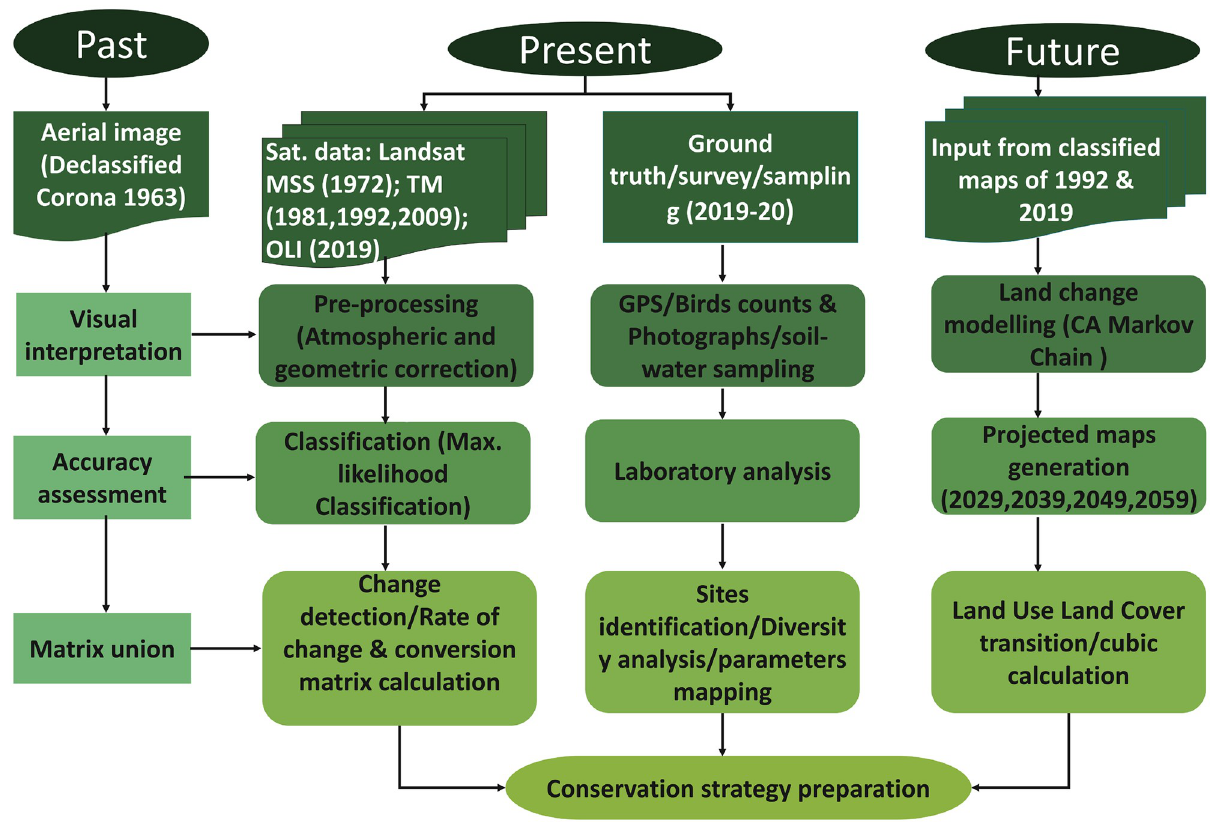
Fig 2. Methodology